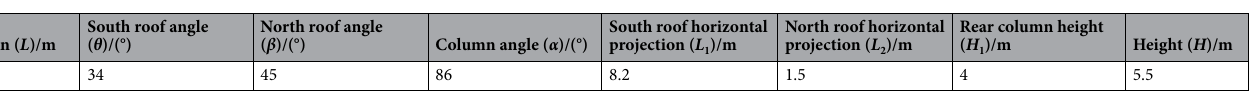
Table 1. Parameters of greenhouse